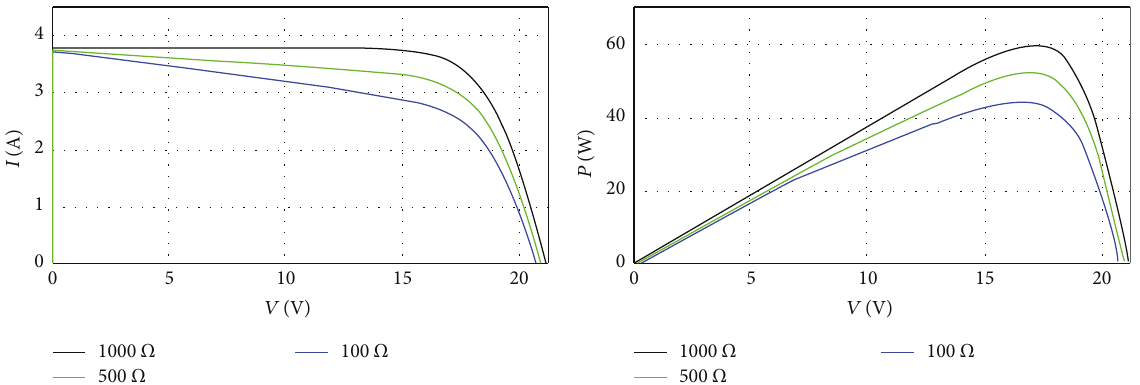
Figure 10: I ‐ V and P ‐ V curves for di ff erent values of R